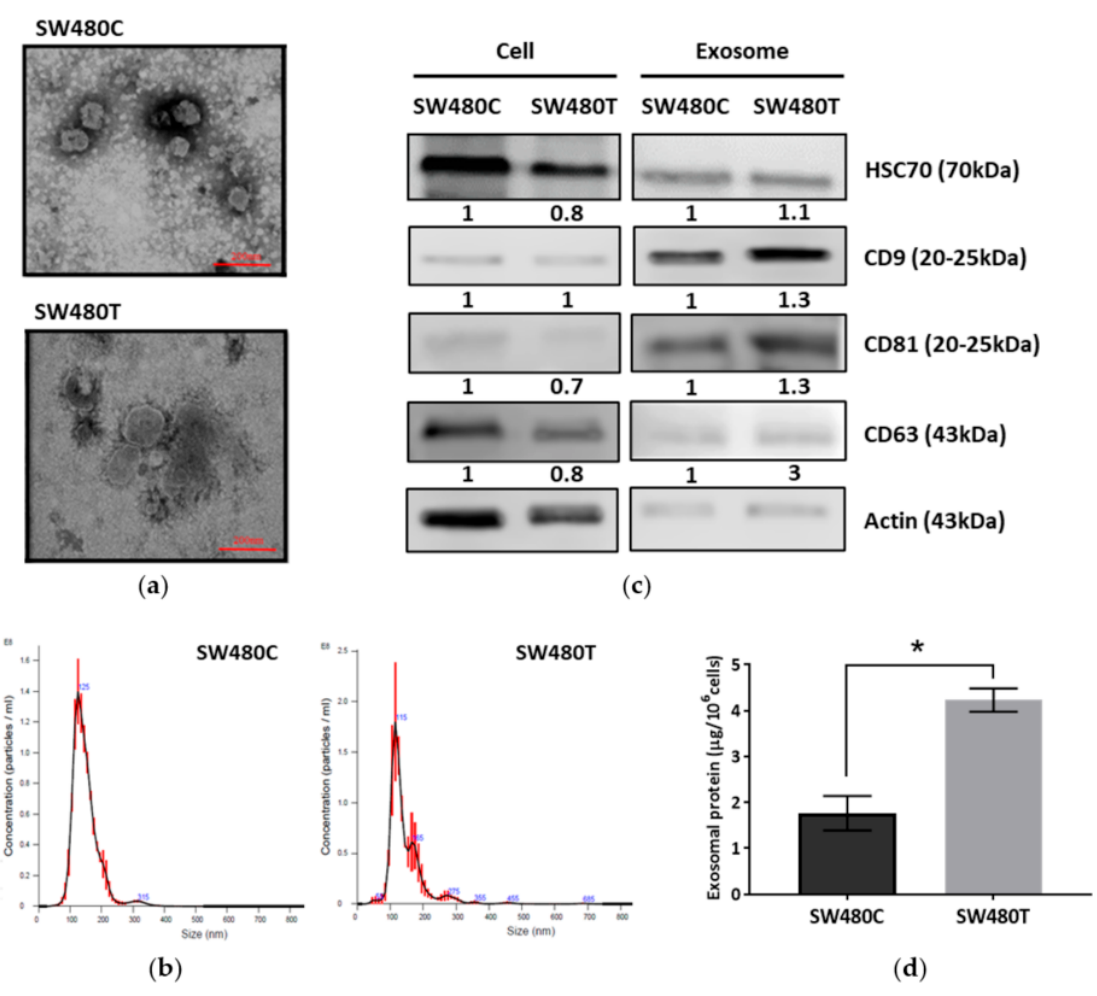
Figure 3. Characterization of exosomes derived from SW480 cells (SW480C—Control cells; SW480T—FTS-treated cells). ( a ) Transmission electron micrographs; ( b ) Particle size analysis by Nanosight; ( c ) Western blot analysis of exosomal markers with actin as the loading control; ( d ) Exosome production analyzed based on exosomal protein yield. * indicates significance difference ( n = 3, p < 0.05; unpaired t -test).